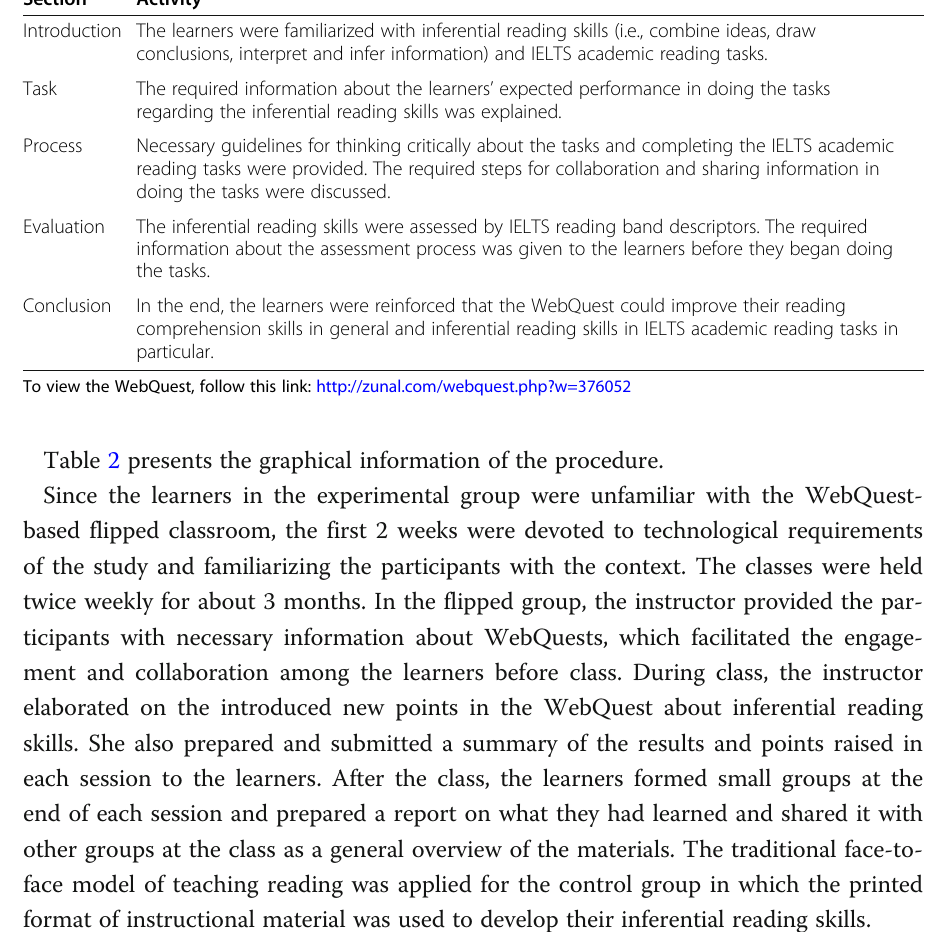
Table 1 A brief description of the WebQuest designed for the study Section